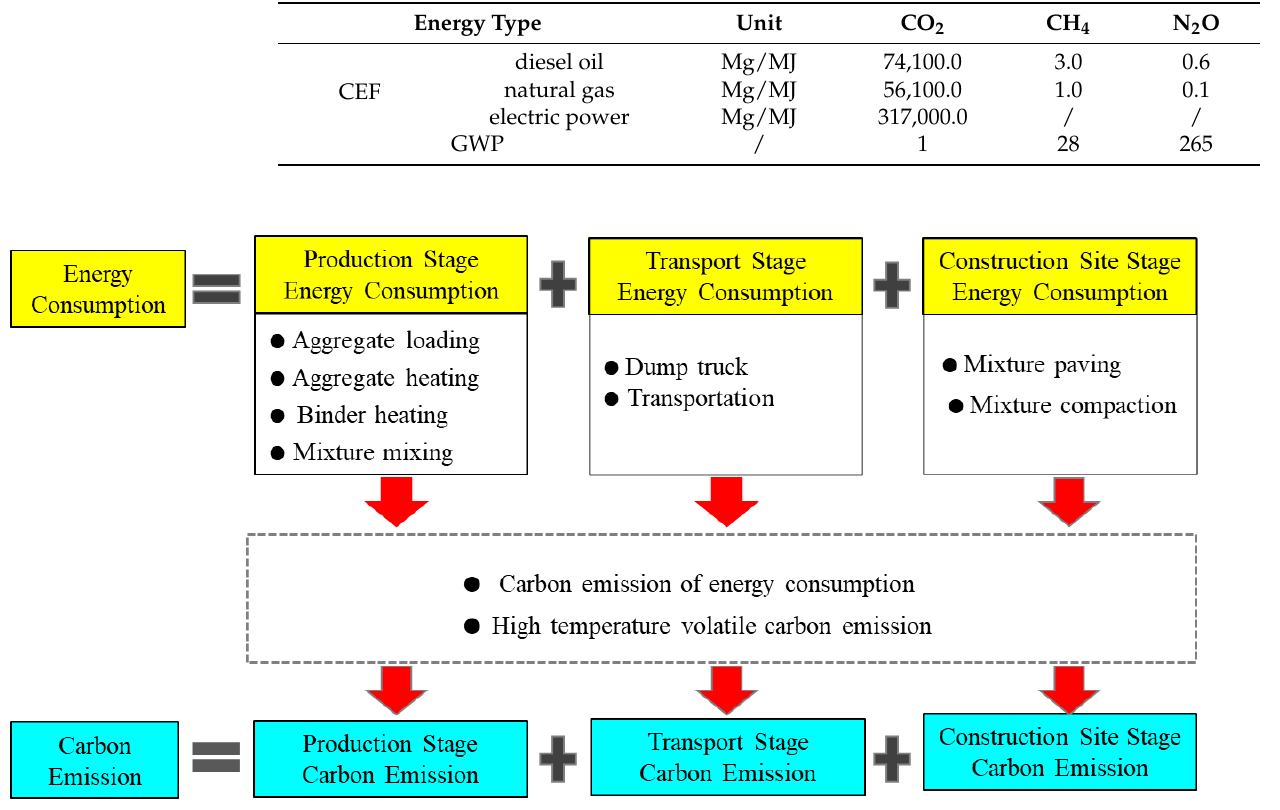
Figure 5. Energy consumption and carbon emission of the mixtures.